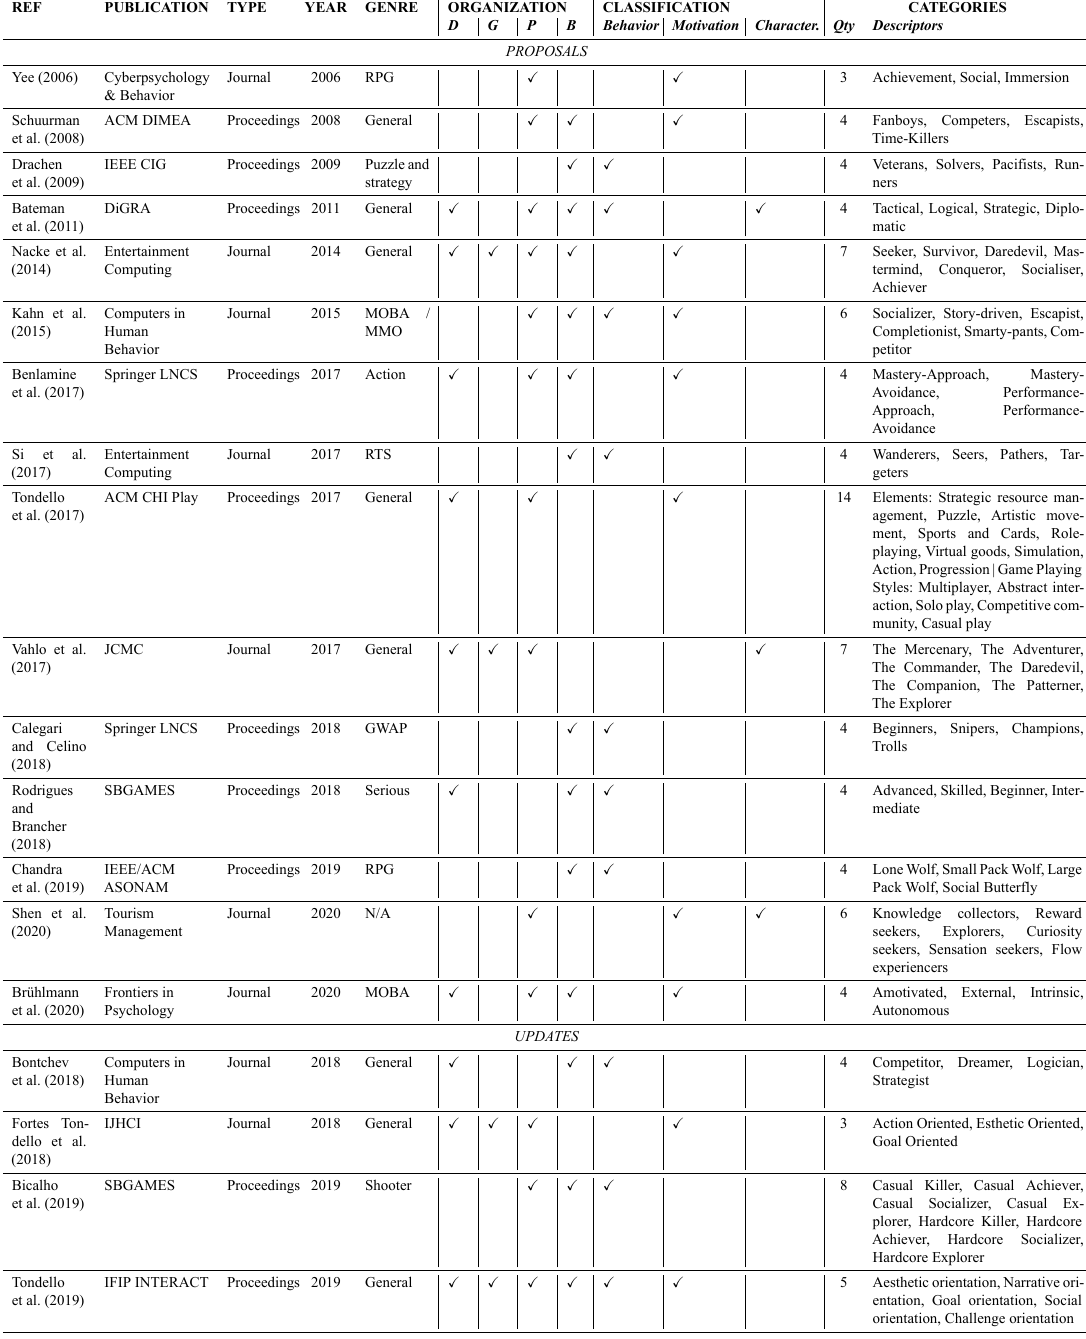
Table 2. Summary of the 19 identified classifications